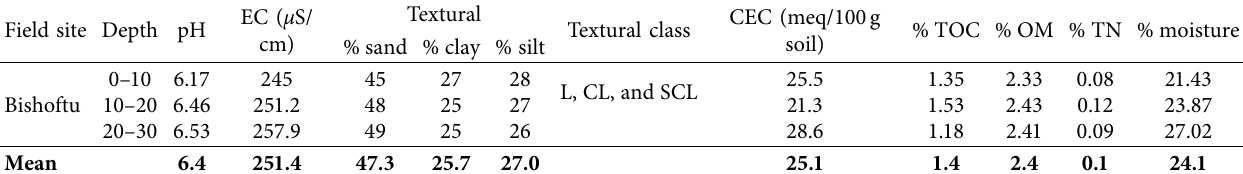
Table 3: The physiochemical properties laboratory result for the farm field.